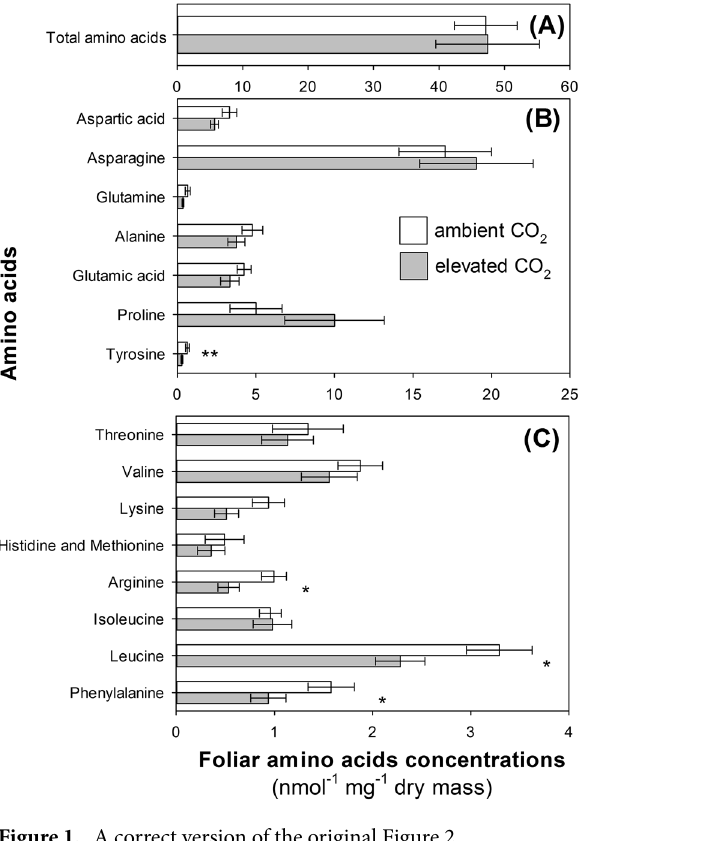
Figure 1. A correct version of the original Figure